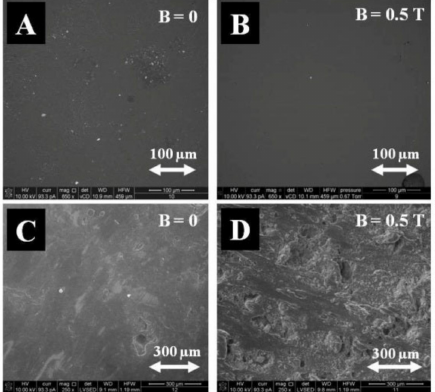
Figure 8. Microstructure of PLA and starch composite polymerized without CMF ( A ) and with the application of CMF ( B ), the image of backscattered electrons BSE as well as PLA and Fe 3 O 4 composite polymerized without the application of CMF ( C ) and with the application of CMF ( D ), magnification 650 × and 250 ×